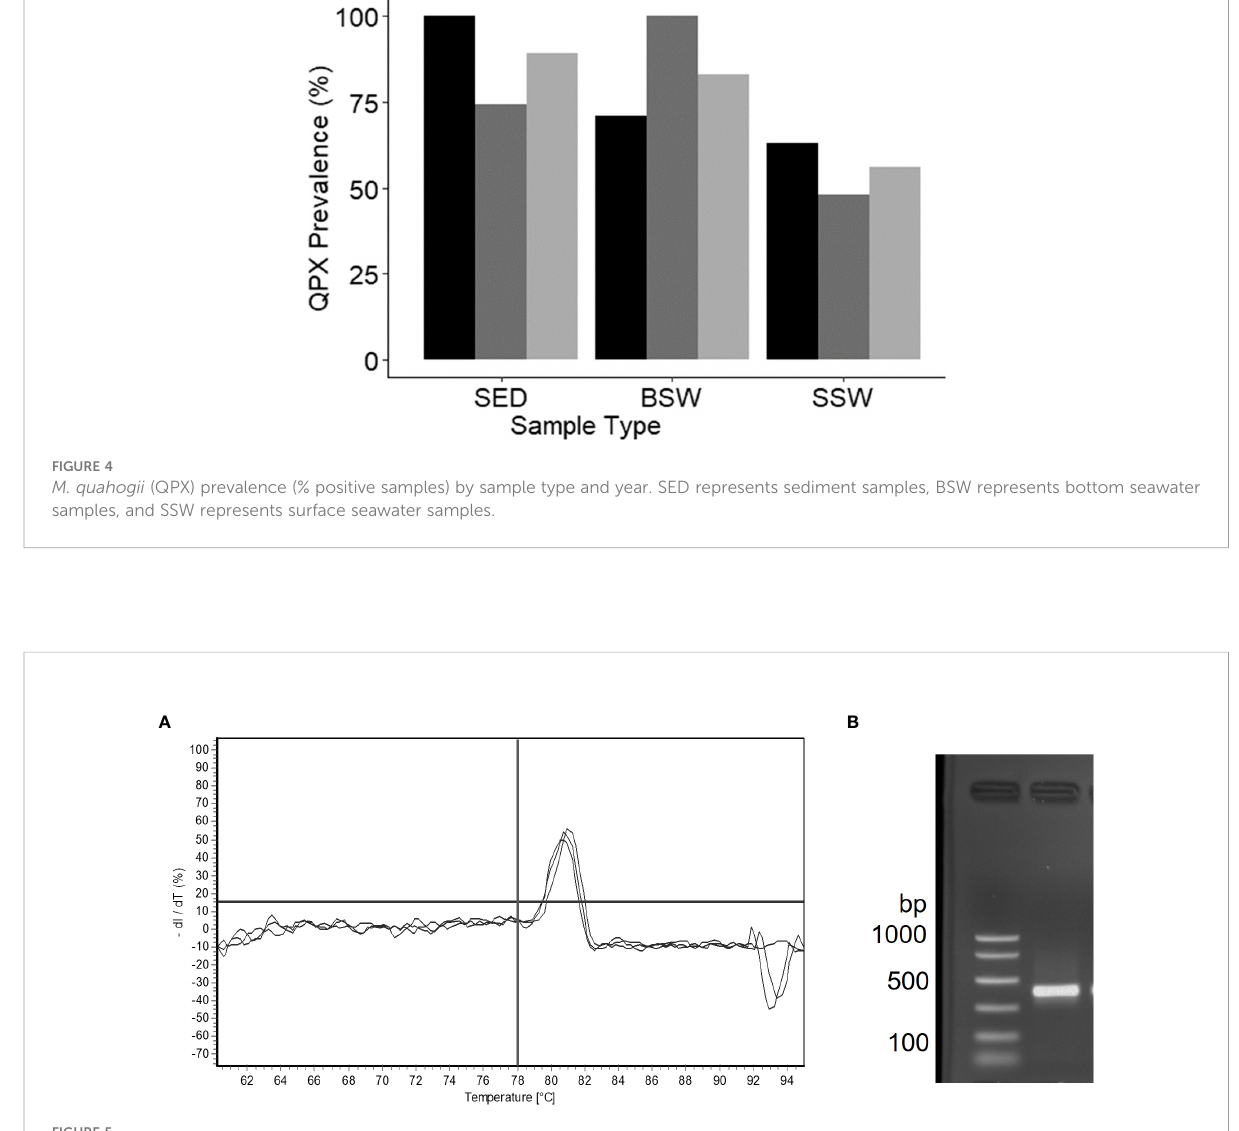
suggesting that inhibition was minimal with PCR ef fi ciencies within 10% of the ef fi ciency of the standard curve used for quanti fi cation. Close examination of ampli fi cation and melt curves revealed that some samples had linear instead of exponential quanti fi cation curves with a broad melt curve peak (T m ~72° C). The linear ampli fi cation curves were easily identi fi ed as they also crossed the threshold very early (low C q value;